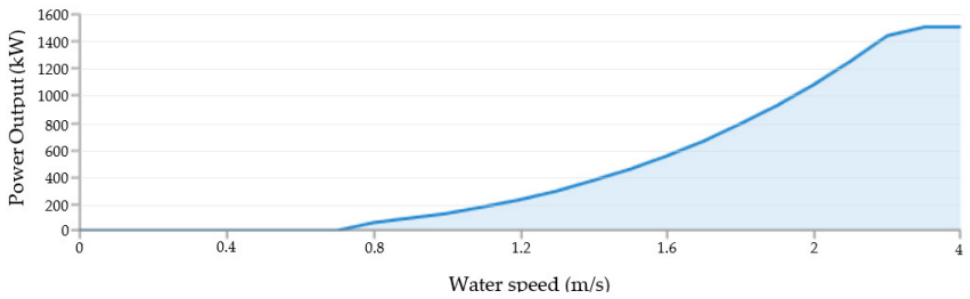
Figure 15. Power Curve of AR1500 (from